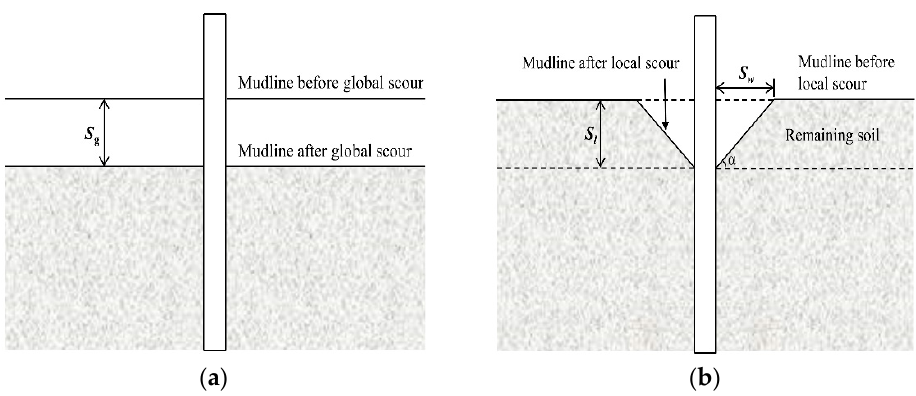
Figure 4. Global scour ( a ) and local scour ( b ) around pile foundations.